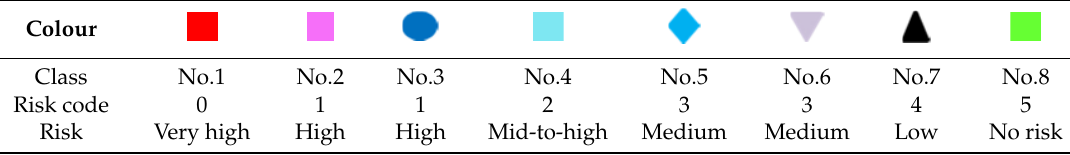
Table 2. Classes, symbols, and risk codes for steel engineering constructions.